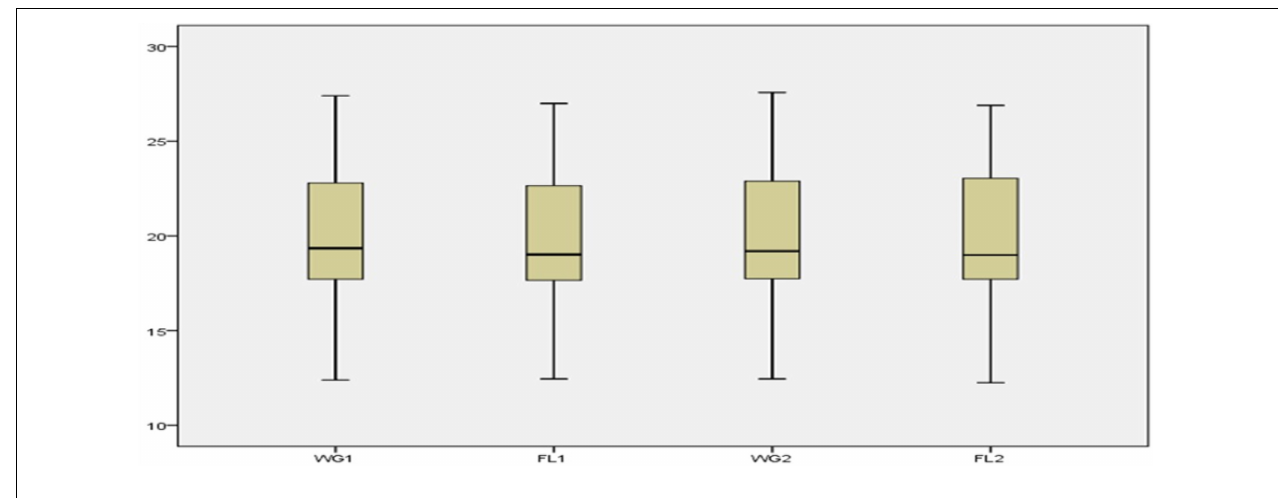
FIGURE 2 | Box plots of WG1, FL1, WG2, and FL2.